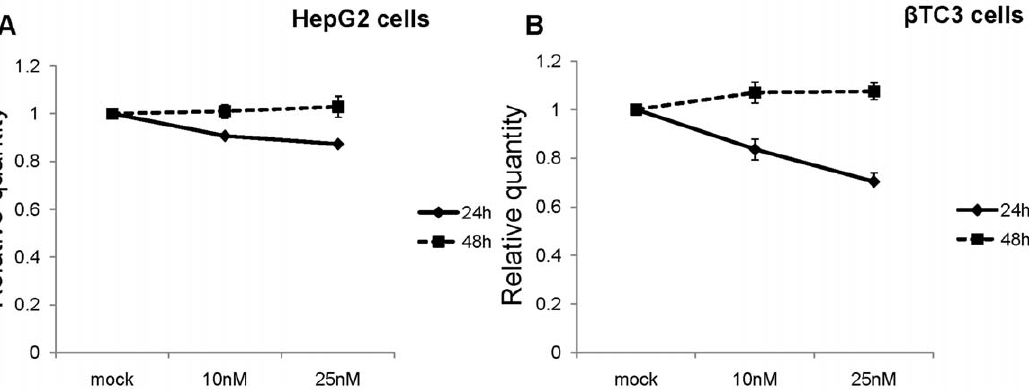
Figure 3. QPCR analysis of HMGCoAR mRNA. (A) HepG2 cells and (B) b -TC3 cells transfected with 10 and 25 nM LNA ASO and analyzed at 24 h and 48 h post-transfection. Human S14 and mouse S16 mRNAs were used for normalization.